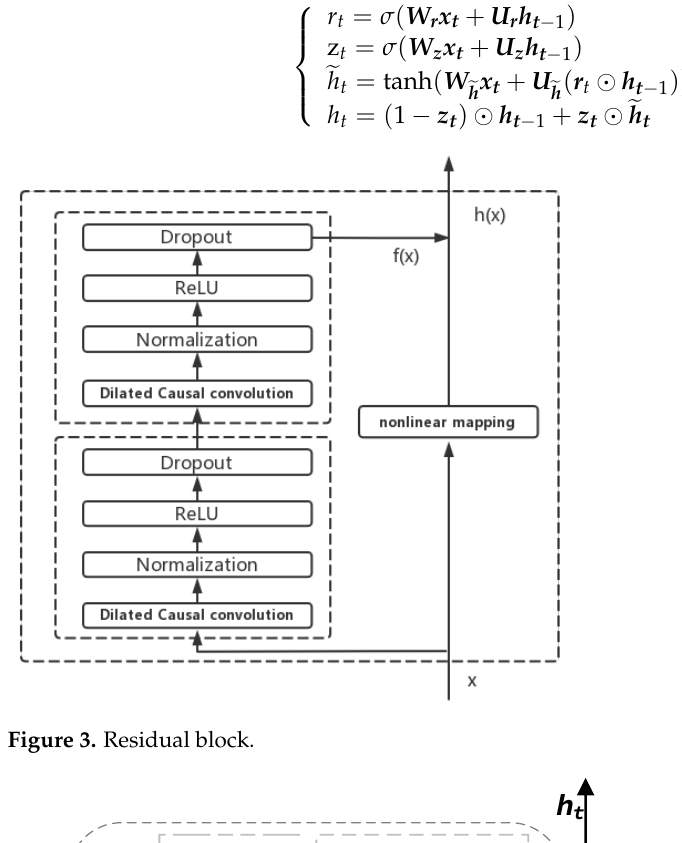
Figure 3. Residual block.